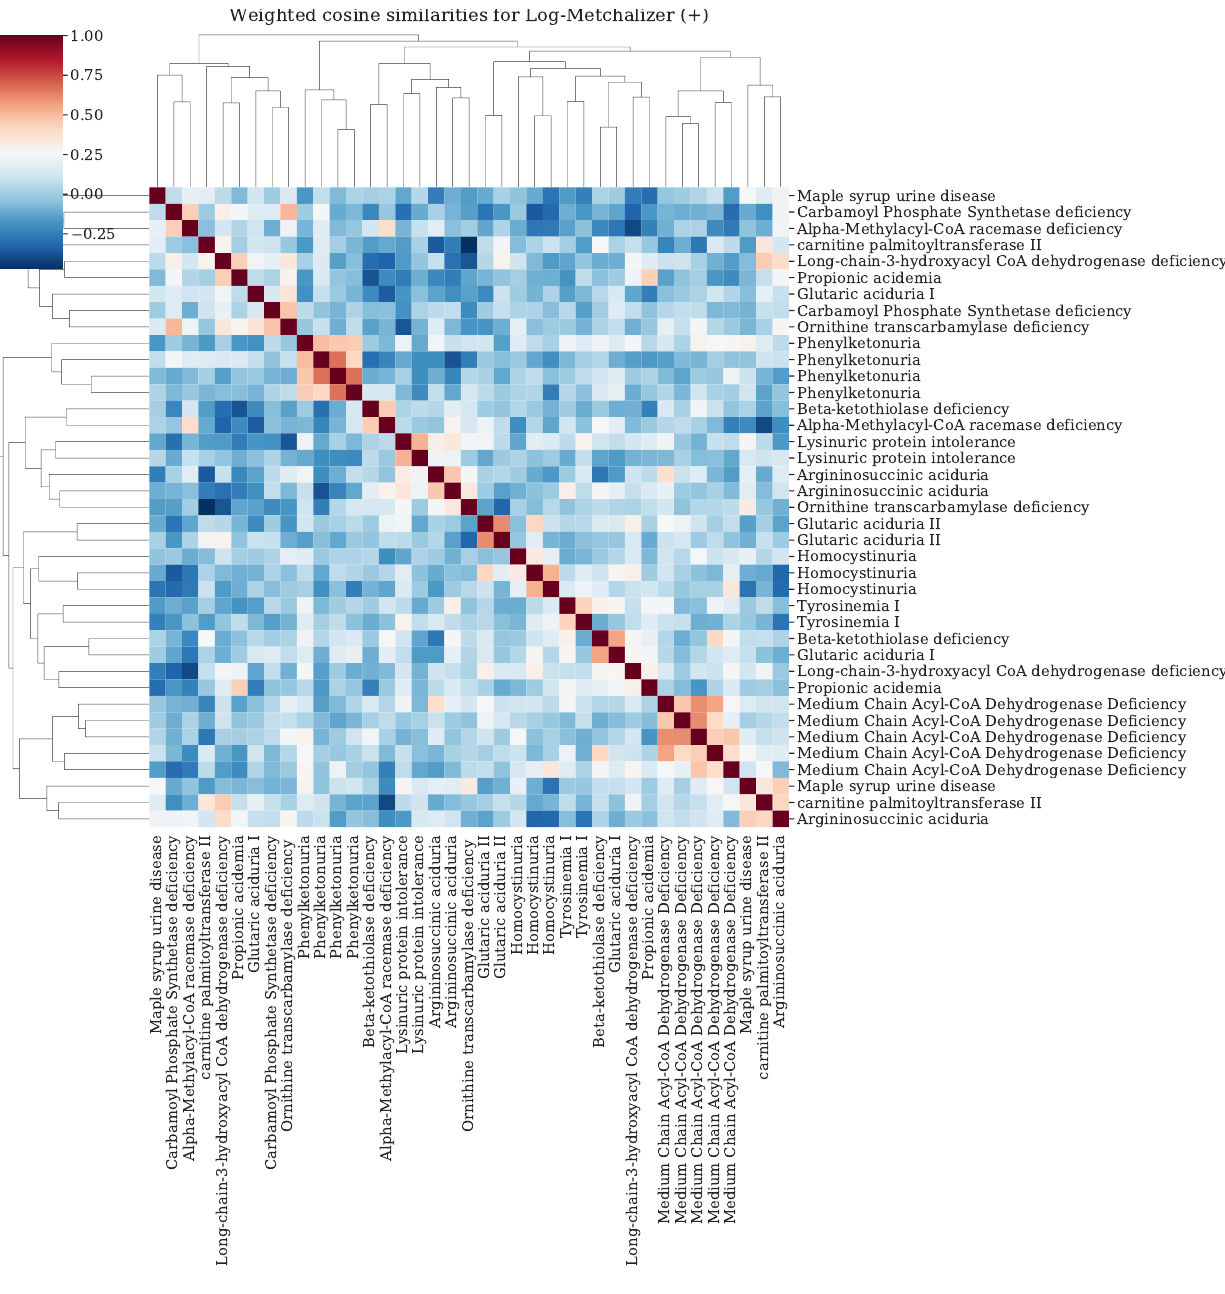
Figure A11. Clustermap of the weighted cosine similarities for IEM patients in positive ion mode using Log-Metchalizer